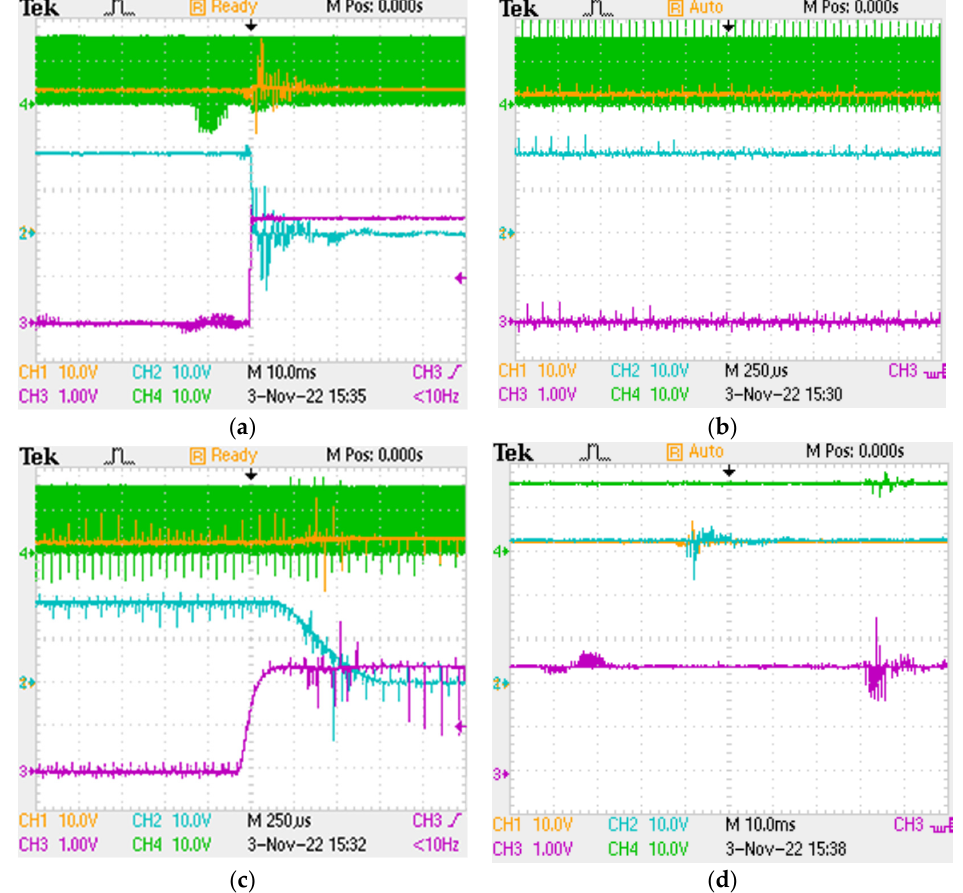
Figure 20. The experimental waveforms of S 3 short-circuit fault. ( a ) Overall stages; ( b ) the waveform of three-level mode before S 3 fault; ( c ) the waveform of S 3 short-circuit fault during fault; ( d ) the waveform of two-level mode after S 3 fault.